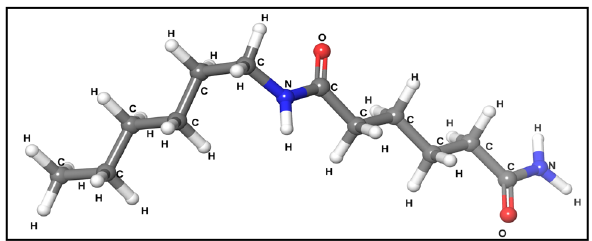
Figure 2: Structure of nylon 66.